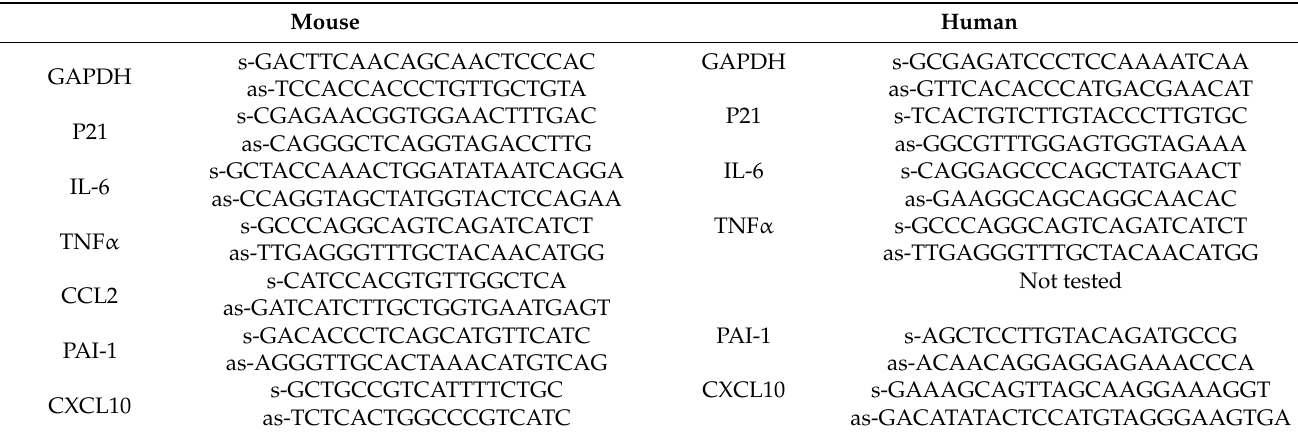
Table 1. Primers used in quantitative real time